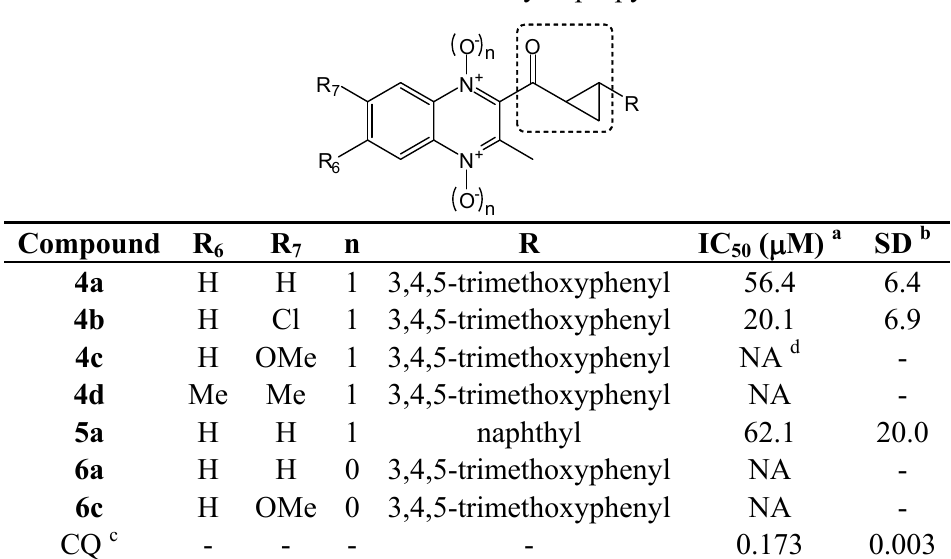
Table 2. In vitro activities of cyclopropyl